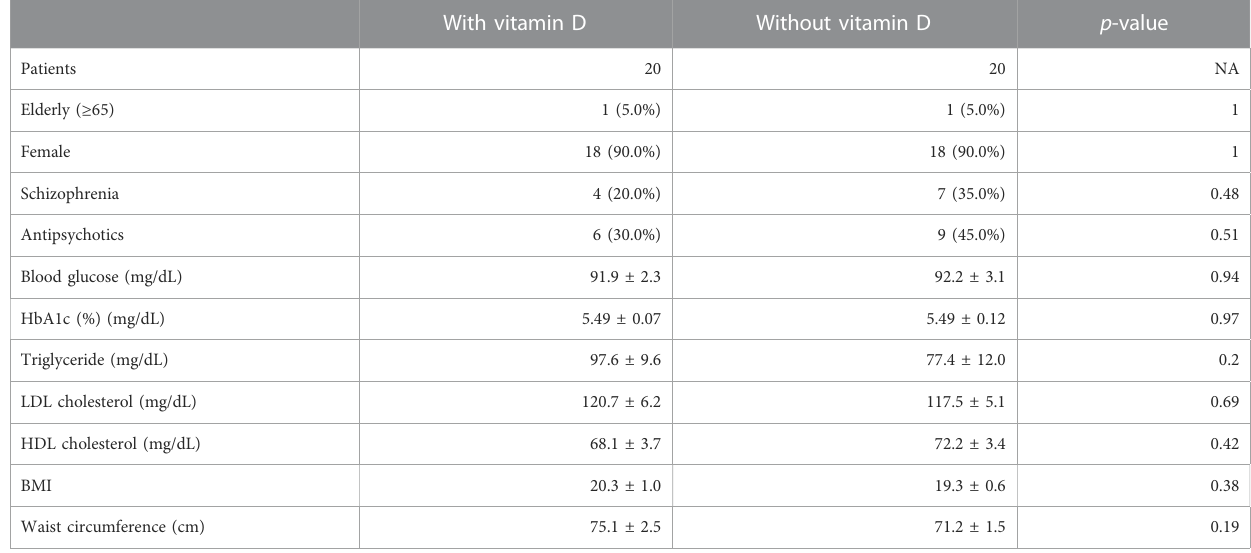
TABLE 2 Population characteristics of the patients in the propensity score-matched olanzapine cohort extracted from the JMDC data; quanti fi able data are given as means ± SEM. With vitamin